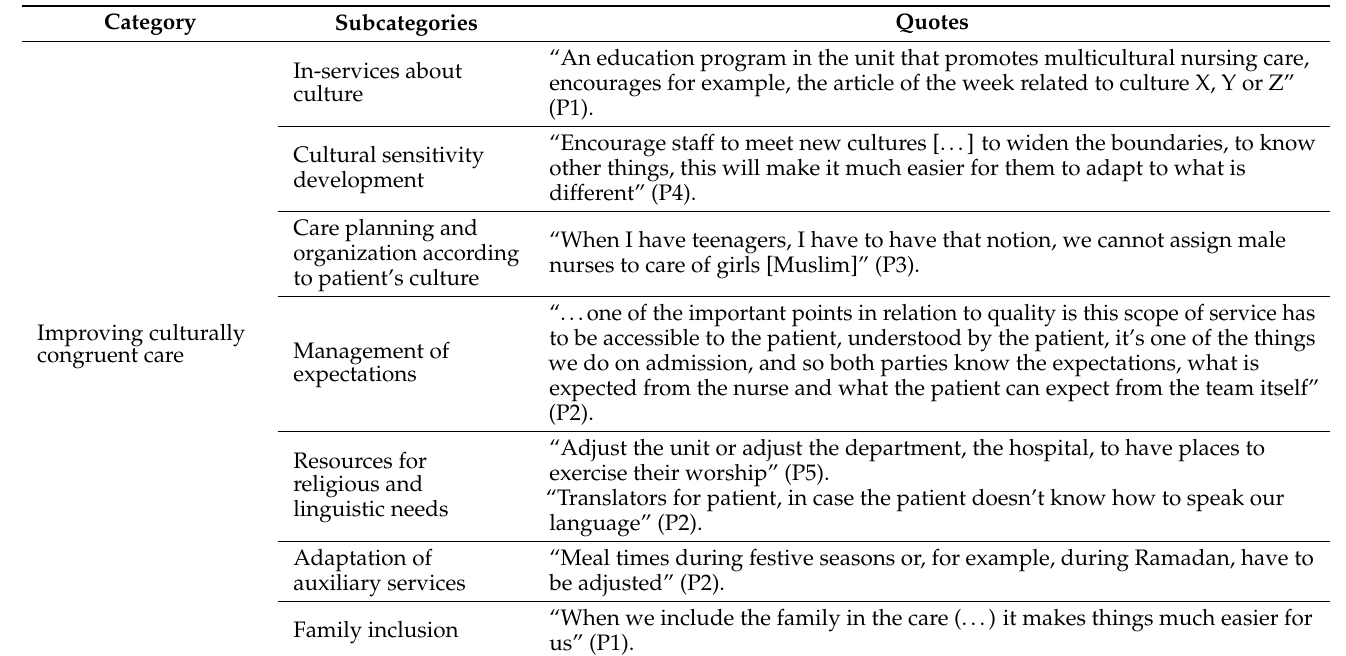
Table 3. Subcategories of the “Improving culturally congruent care” category and participants’